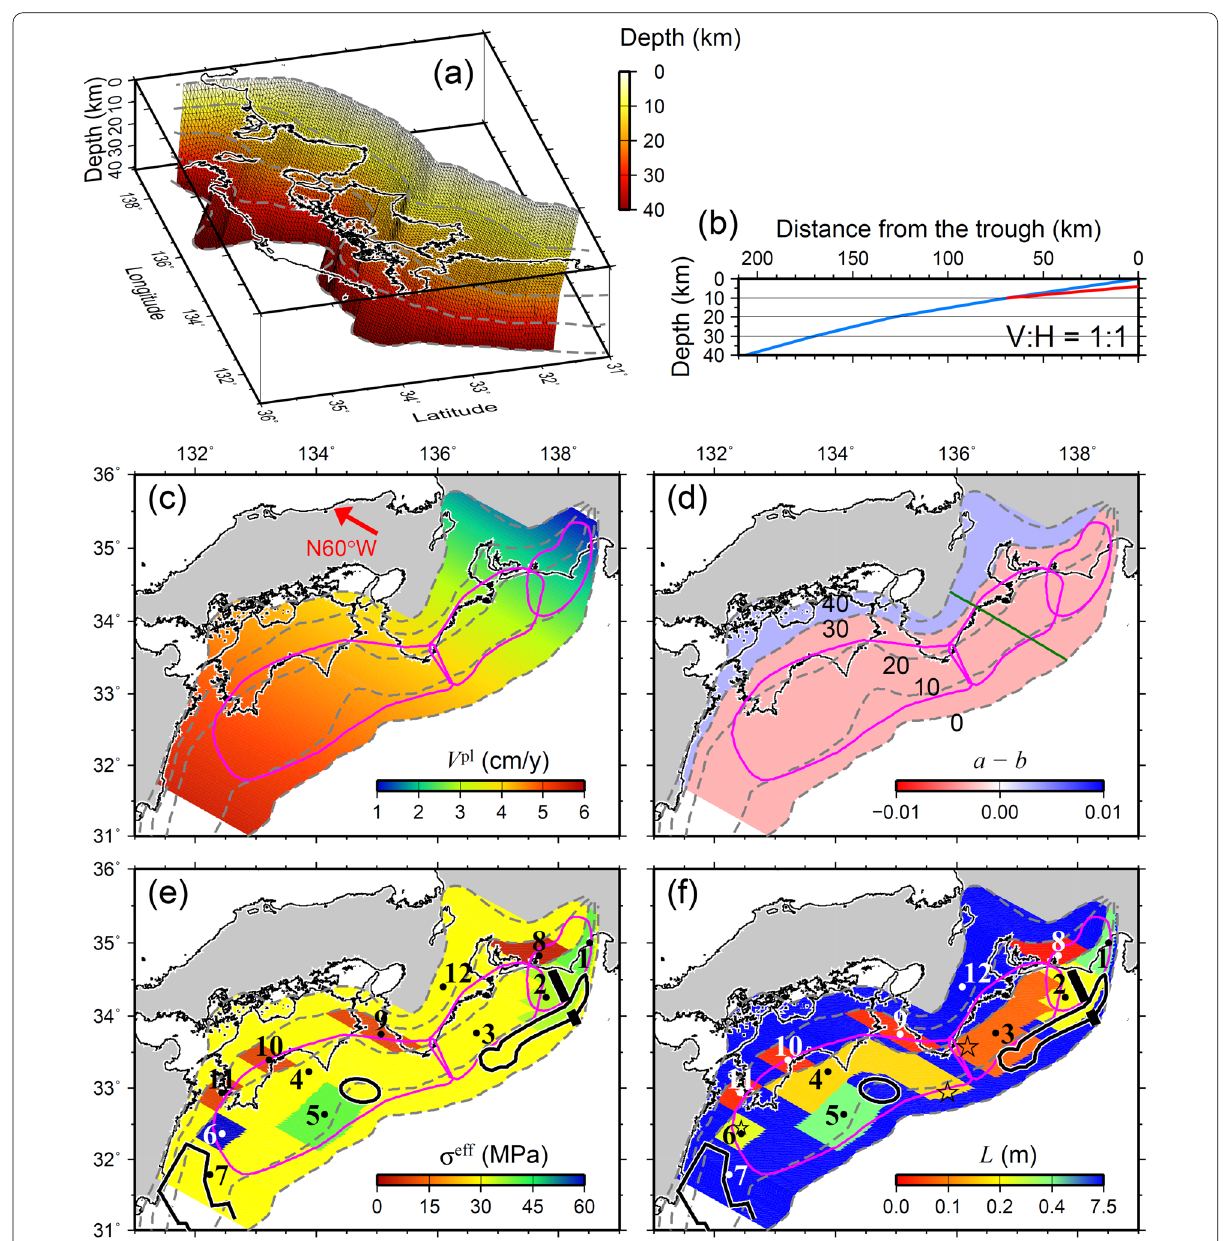
Fig. 4 Parameter settings. a Three-dimensional plate boundary, represented by 13,604 triangular cells. Vertical dimension is exaggerated. Broken gray lines are depth contours of the top of the subducting Philippine Sea plate (Hirose et al. 2008). b Cross section along the green line in d showing the plate interface in the model (blue) and the actual plate interface shallower than 10 km (red). c – f Map views of c plate convergence rate V pl ; d friction parameter ( a − b ); e effective normal stress σ eff , and ( f ) characteristic displacement L (note that the color scale is not linear); d – f show the parameter settings of the best model. The red arrow in c indicates the average direction of movement of the Philippine Sea plate relative to the continental plate used in this study. The numbered polygons in e , f are assigned specific values, and the dots are reference points. Other symbols are as shown in Fig.